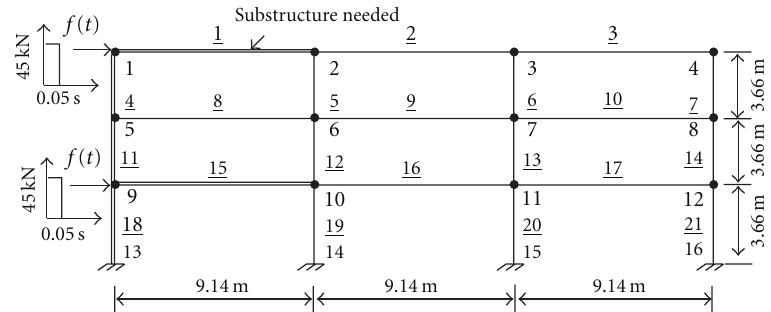
Figure 1: A three-bay three-story frame under impulsive